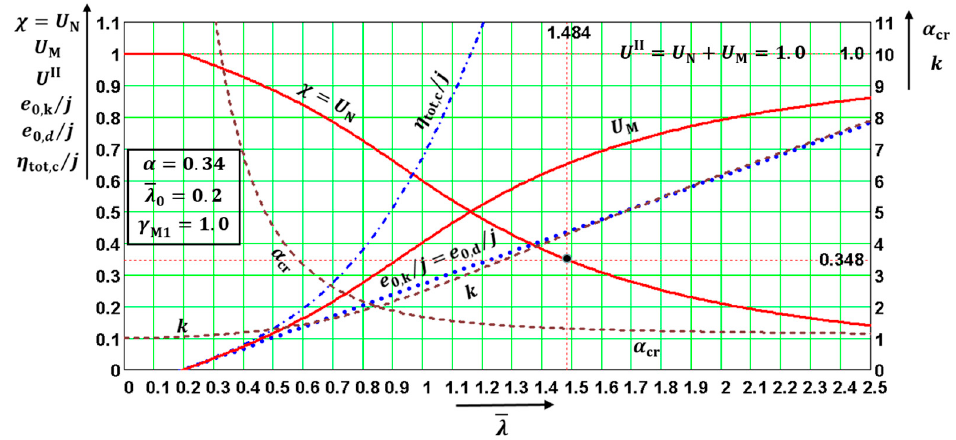
Figure 7. Relevant quantities for α = 0.34, γ M1 = 1.0, and N Ed = N b,Rd = χ Af y / γ M1 . Only Figure 7. Relevant quantities for 𝛼 = 0.34, 𝛾 (cid:2897)(cid:2869) = 1.0 , and 𝑁 (cid:2889)(cid:2914) = 𝑁 (cid:2912),(cid:2902)(cid:2914) = 𝜒𝐴𝑓 (cid:2935) 𝛾 (cid:2897)(cid:2869) ⁄ . Only quanti- Figure 7. Relevant quantities for 𝛼 = 0.34, 𝛾 (cid:2897)(cid:2869) = 1.0 , and 𝑁 (cid:2889)(cid:2914) = 𝑁 (cid:2912),(cid:2902)(cid:2914) = 𝜒𝐴𝑓 (cid:2935) 𝛾 (cid:2897)(cid:2869) ⁄ . Only quanti- Figure 7. Relevant quantities for 𝛼 = 0.34, 𝛾 (cid:2897)(cid:2869) = 1.0 , and 𝑁 (cid:2889)(cid:2914) = 𝑁 (cid:2912),(cid:2902)(cid:2914) = 𝜒𝐴𝑓 (cid:2935) 𝛾 (cid:2897)(cid:2869) ⁄ . Only quanti- ties 𝛼 (cid:2913)(cid:2928) ,𝑘,and 𝑒 (cid:2868),(cid:2914) 𝑗⁄ are functions of safety factor 𝛾 (cid:2897)(cid:2869) . quantities α cr , k , and e 0,d / j are functions of safety factor γ M1 . ties 𝛼 (cid:2913)(cid:2928) ,𝑘,and 𝑒 (cid:2868),(cid:2914) 𝑗⁄ are functions of safety factor 𝛾 (cid:2897)(cid:2869) . ties 𝛼 (cid:2913)(cid:2928) ,𝑘,and 𝑒 (cid:2868),(cid:2914) 𝑗⁄ are functions of safety factor 𝛾 (cid:2897)(cid:2869) .